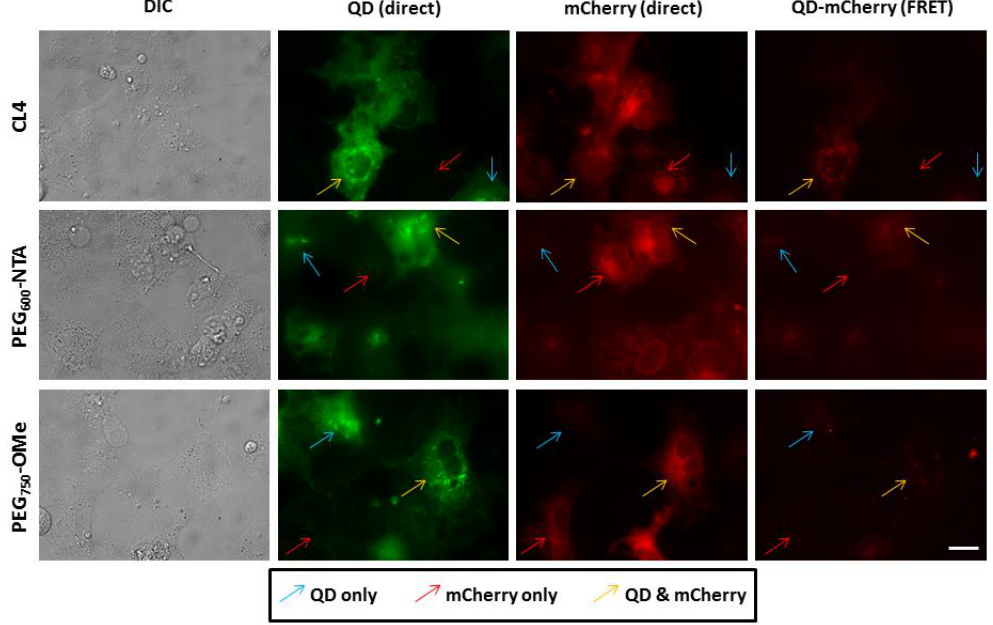
Figure 4. Assembly of QDs and mCherry at the cytofacial leaflet of the plasma membrane. COS-1 cells expressing mCherry proteins on the cytofacial leaflet of the plasma membrane (as a fusion to CD1b) were microinjected with QDs coated with CL4, PEG 600 -NTA and PEG 750 -OMe. Imaging was performed as described for Figure 3. Note the lower level of mCherry expression due to its localization at the plasma membrane. The FRET signal for the CL4 QDs bound to membrane expressed mCherry was ~50% that observed for cytosolic mCherry. Scale bar is 20 μ m.